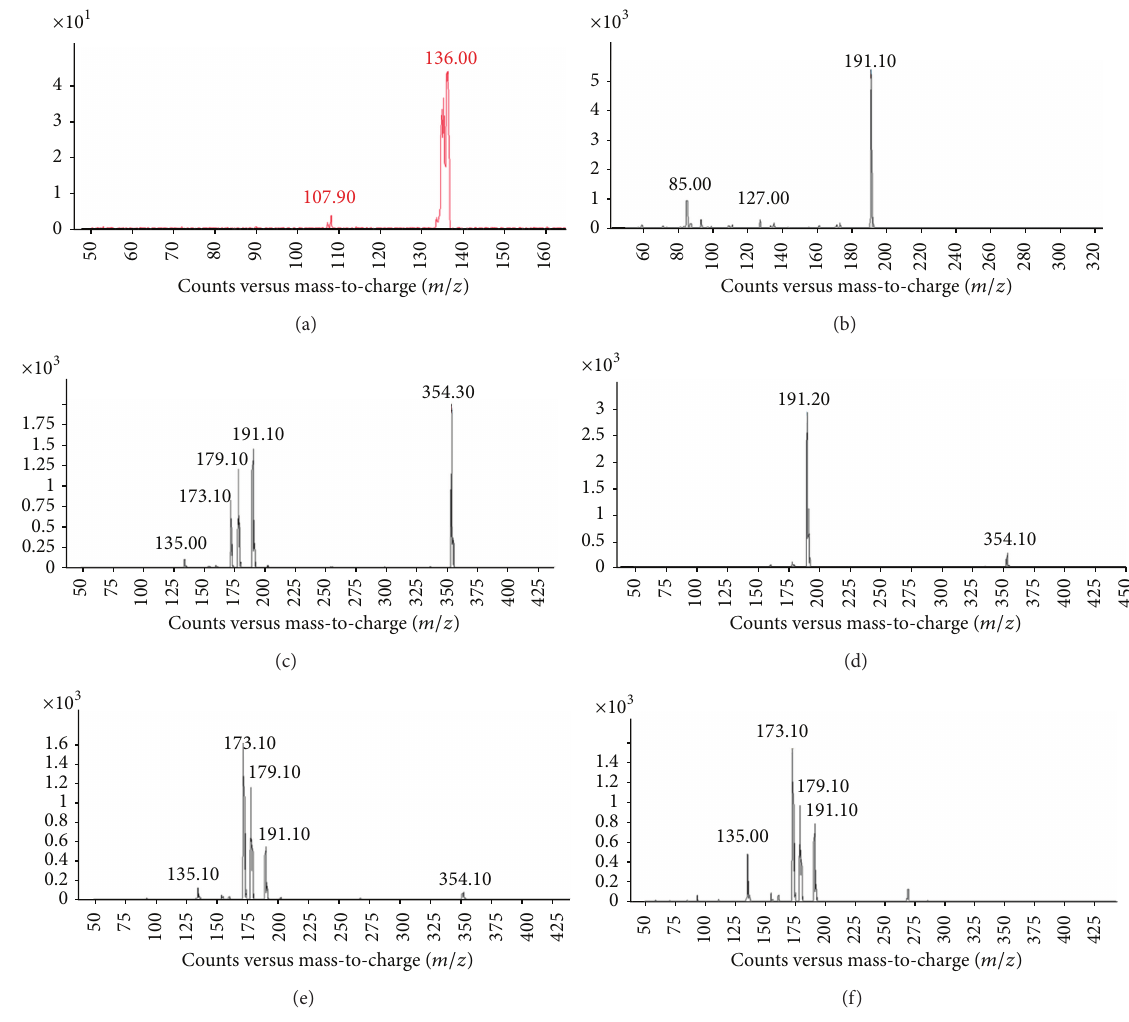
Figure 2: HPLC-MS-MS spectra of phenolic acids ( 𝑚/𝑧 179 of caffeic acid (a), 𝑚/𝑧 353 of 3-o-caffeoylquinic acid (b), 𝑚/𝑧 515 of 3,4- dicaffeoylquinic acid (c), 𝑚/𝑧 515 of 3,5-dicaffeoylquinic acid (d), 𝑚/𝑧 515 of 1,5-dicaffeoylquinic acid (e), and 𝑚/𝑧 515 of 4,5-dicaffeoylquinic acid